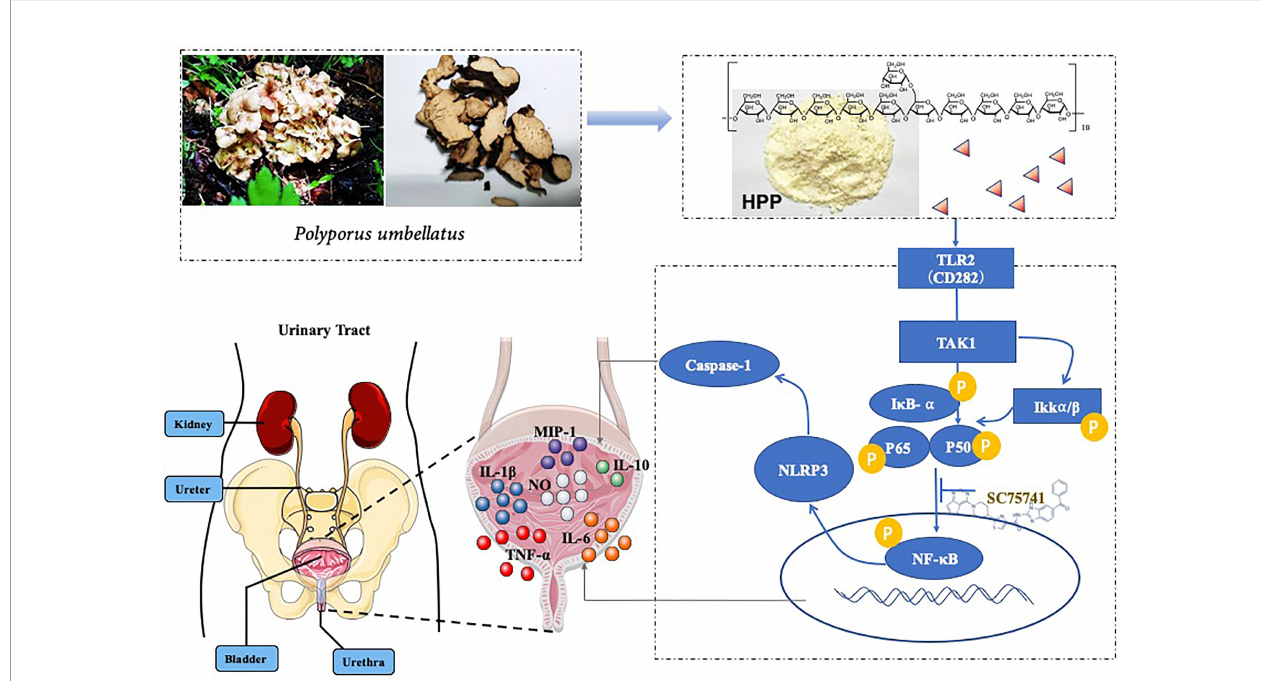
FIGURE 8 | Schematic diagram of HPP promoting the polarization of TAM cells toward